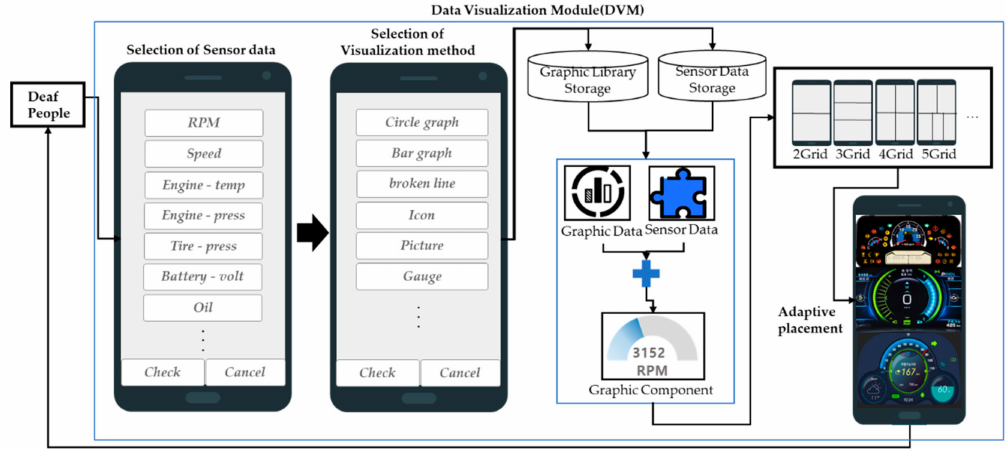
Figure 9. Structure of data visualization